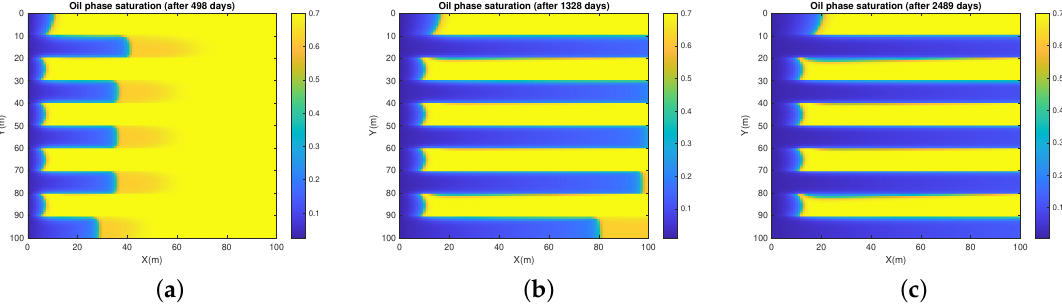
Figure 7. Water saturation at different time for Example 2: ( a ) Water saturation (after 498 days). ( b ) Water saturation (after 1328 days). ( c ) Water saturation (after 2489 days).